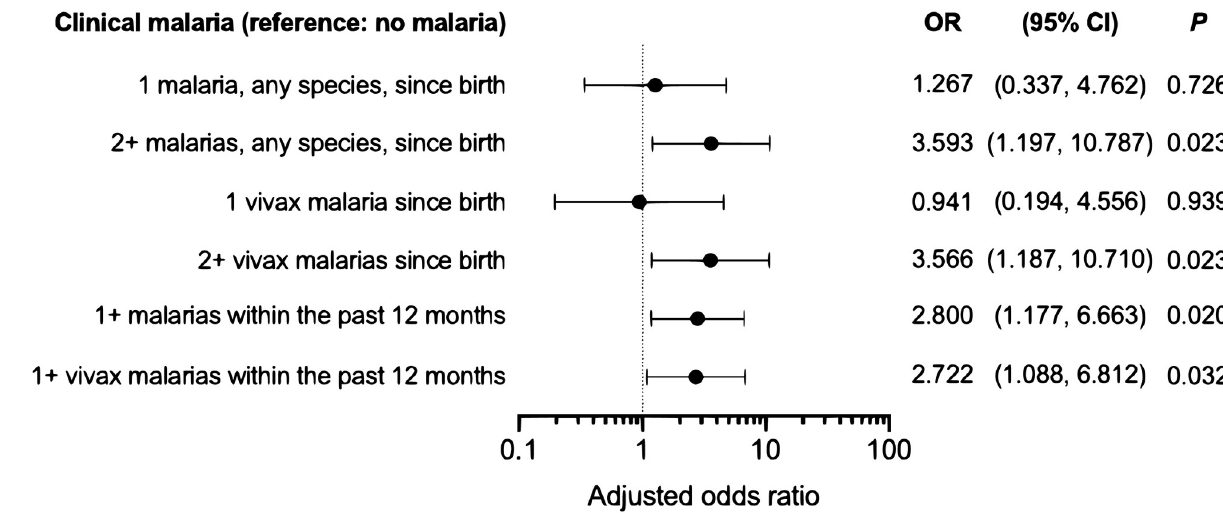
Fig 7. Impact of the frequency and timing of malaria episodes, as well as the infecting malaria parasite species, on the risk of anemia. Odds ratios (OR) indicate the magnitude of association between anemia at the age of 2 years and malaria type (any species or vivax), frequency (1 or 2+), or timing (since birth or within the last 12 months) in MINA-Brazil study participants (n = 860), compared with no malaria, while controlling for the potential confounders listed in Table 3. OR estimates and their respective 95% confidence intervals (95% CIs) and P value were derived from separate multiple logistic regression models in which exposure to malaria was introduced in different